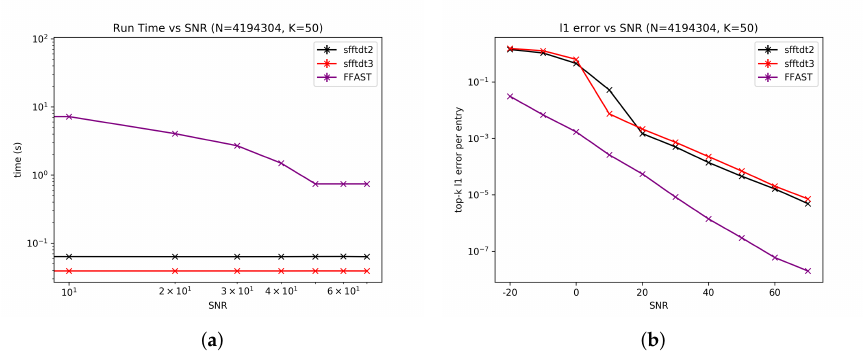
Figure 7. The run time and L 1 -error vs. SNR for the sFFT-DT2.0, sFFT-DT3.0, and R-FFAST algorithm in the general sparse case. ( a ) run time vs. signal size; ( b ) L 1 -error vs. SNR.